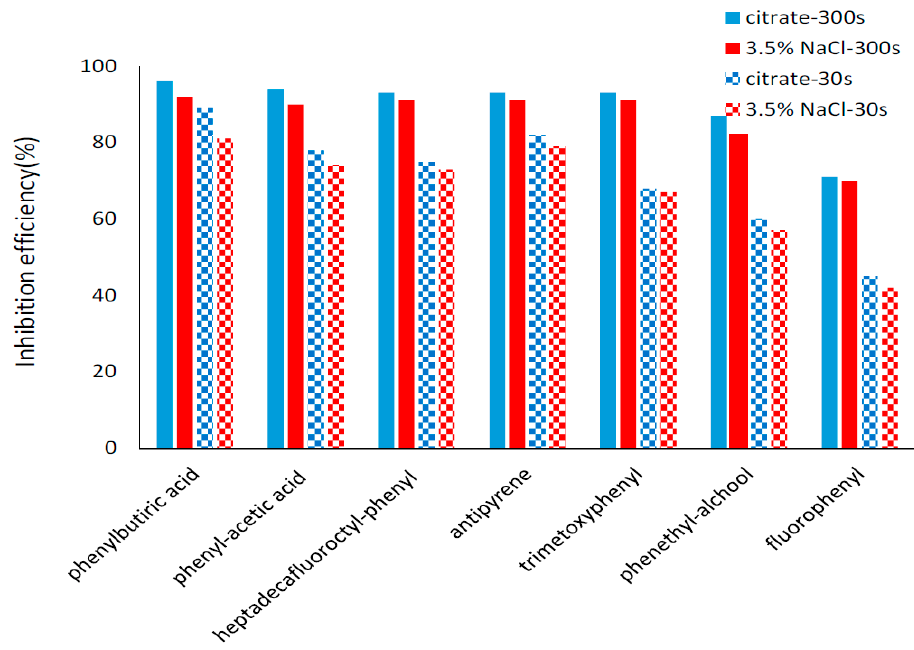
Figure 7. Inhibition efficiencies for the investigated electrodeposited organic layers.